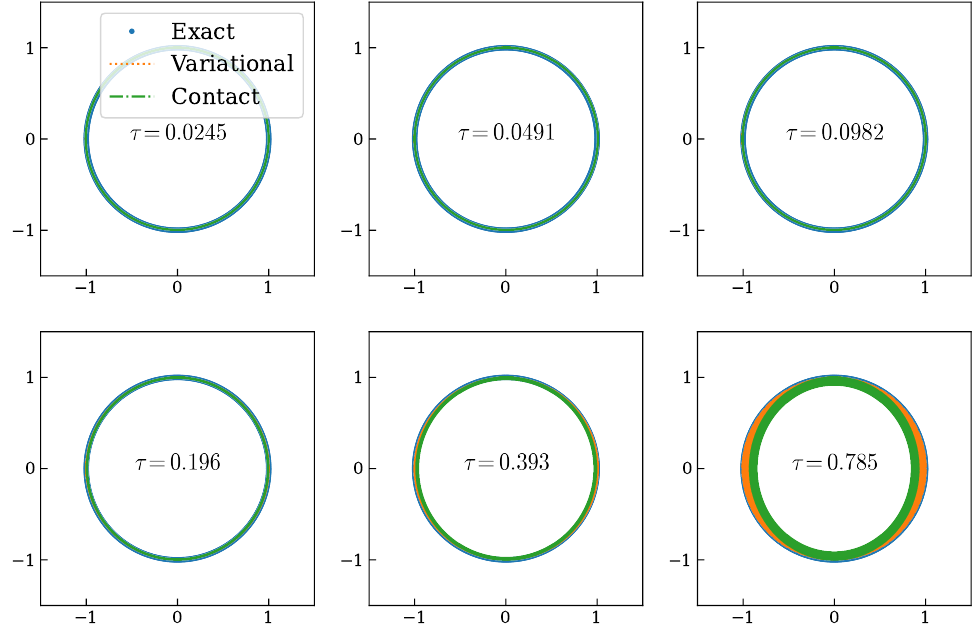
Figure 1. Orbit of the van der Pol oscillator with (cid:101) = 0 (harmonic oscillator) with initial condition ( q ) = ( 0,0,1 ) integrated for different values of the time step τ . The dashed blue line shows 0 , p 0 , s 0 the exact